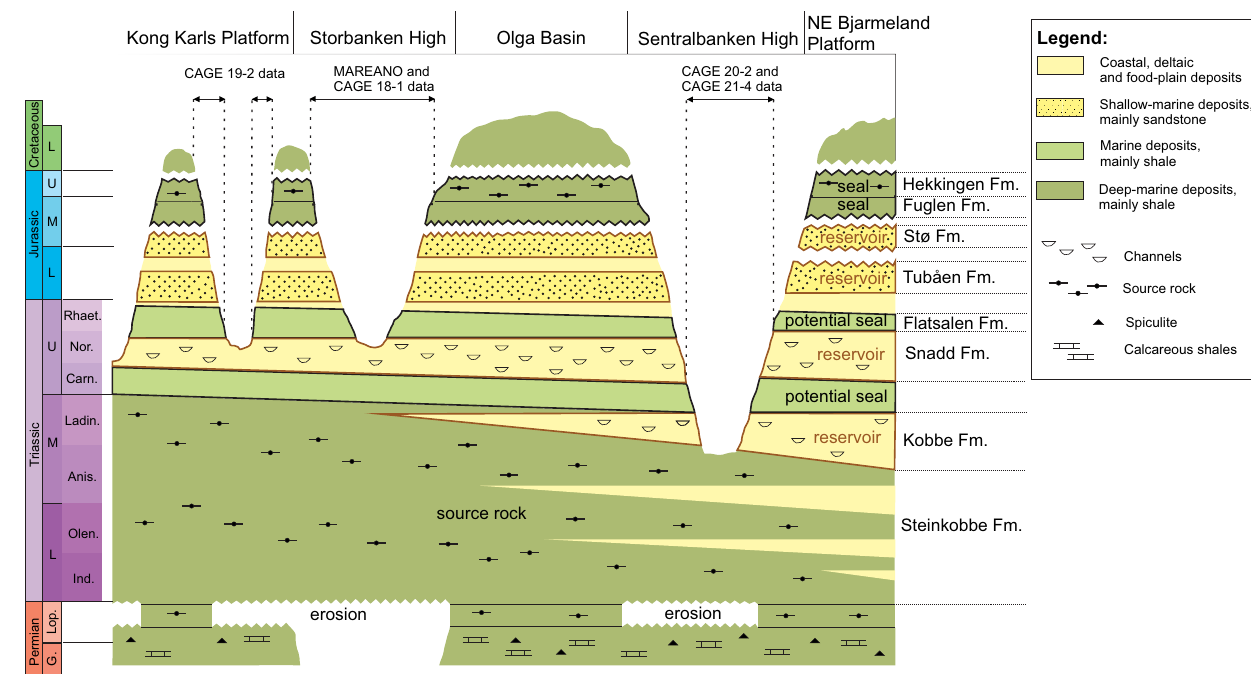
Fig. 2 | Lithostratigraphic diagram for the northern Norwegian Barents Sea shelf 42 . Bold black lines outline potential reservoir formations, bold brown lines outline reservoir units. The erosional topography and thickness of the lithostratigraphic units are not to